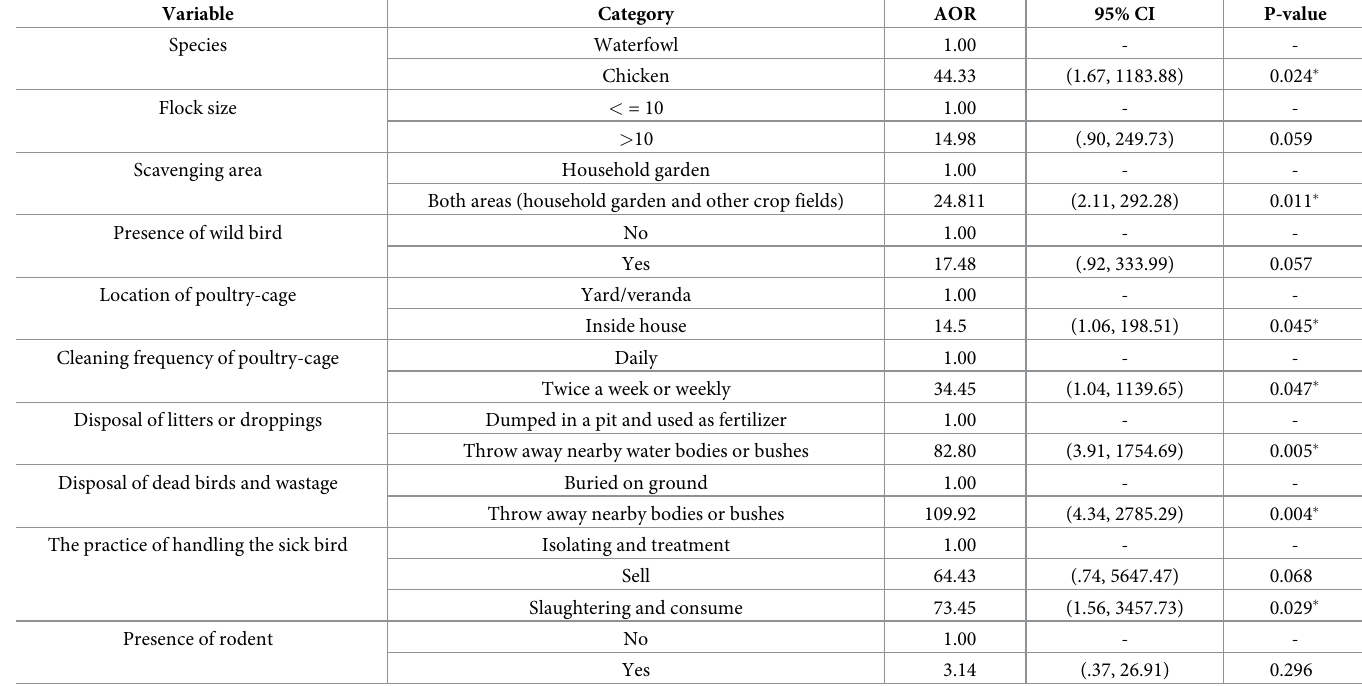
Table 2. Relationship between chicken and waterfowl rearing practices and Influenza A (Results to multivariable logistic regression